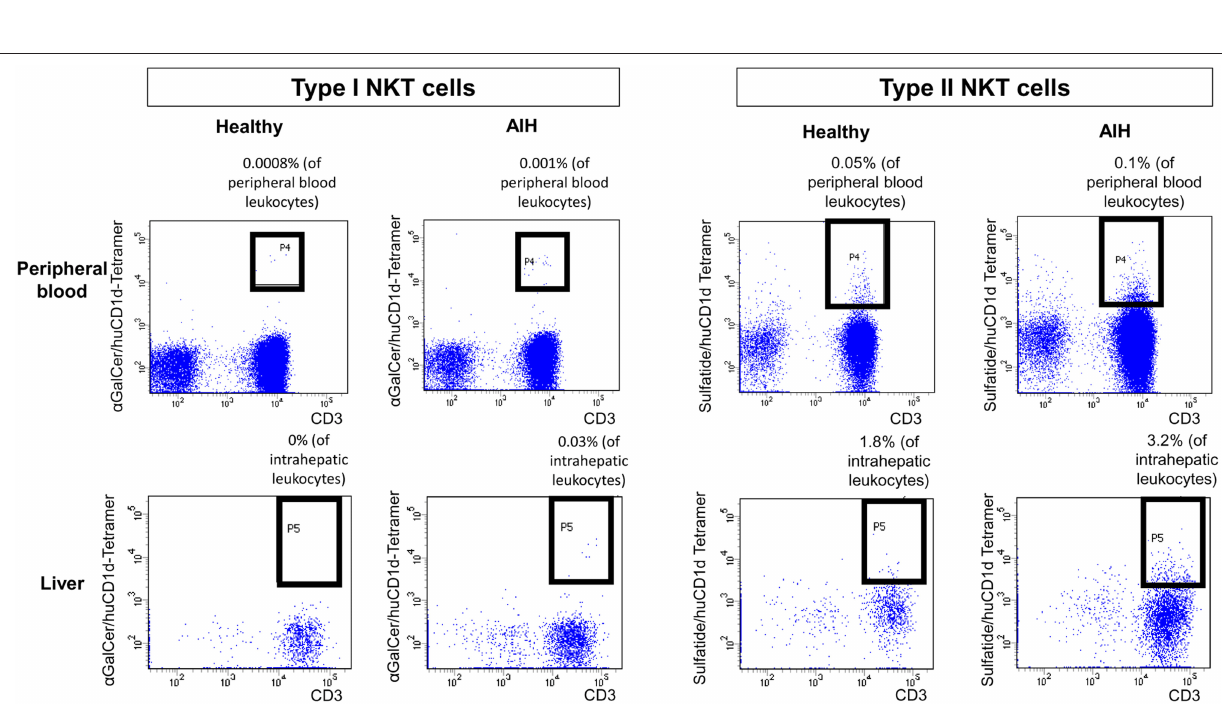
FIGURE 2 | Exemplary flow cytometric stainings of type I and type II NKT cells . Human (hu) CD1d-tetramers loaded either with α GalCer or sulfatide were used to stain type I (left) or type II (right) NKT cells in peripheral blood (upper row) or in liver biopsies (lower row). Representative flow cytometric stainings of type I and type II NKT cells in a healthy subject and a patient with AIH are